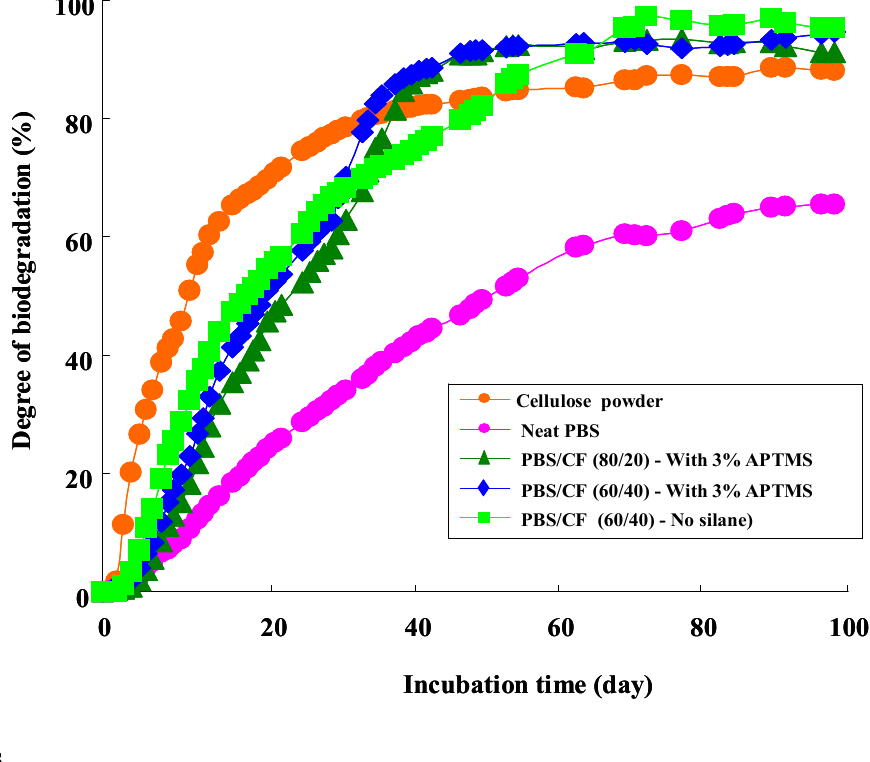
Figure 7. Biodegradation of cellulose powder (microcrystalline), neat PBS, and PBS/CF composites sheets (10 mm × 10 mm × 0.5 mm) with and without silane treatment in controlled compost at 58 °C based on ISO